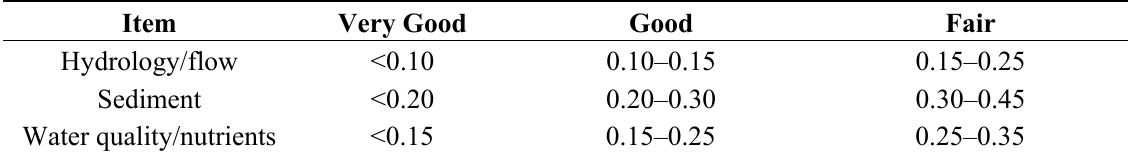
Table 5. General calibration/validation target or tolerances for HSPF application.